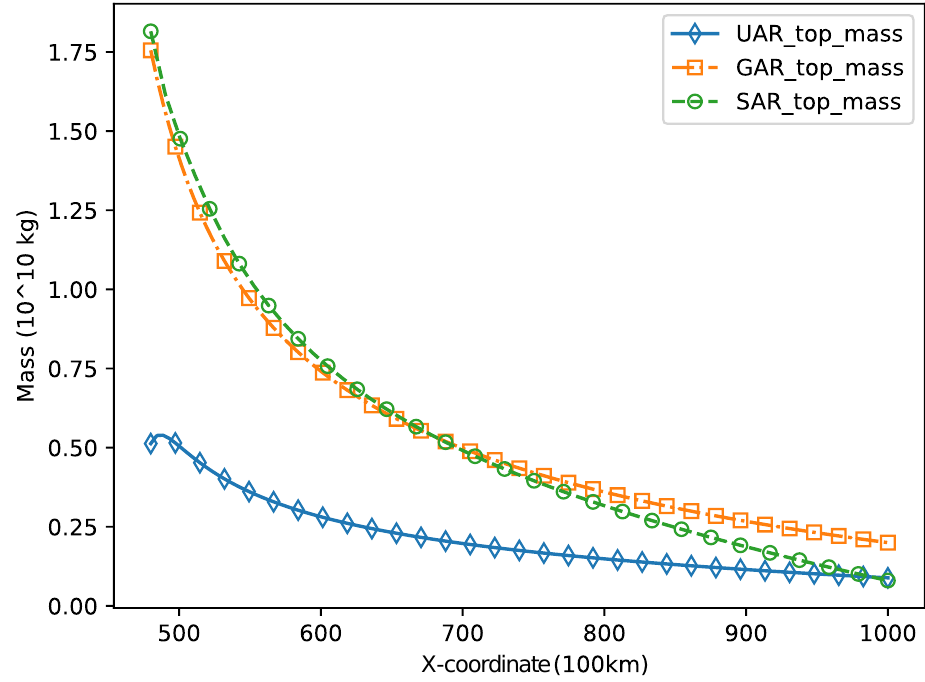
Figure 14. Zenith anchor mass and rope length curve of three space elevator